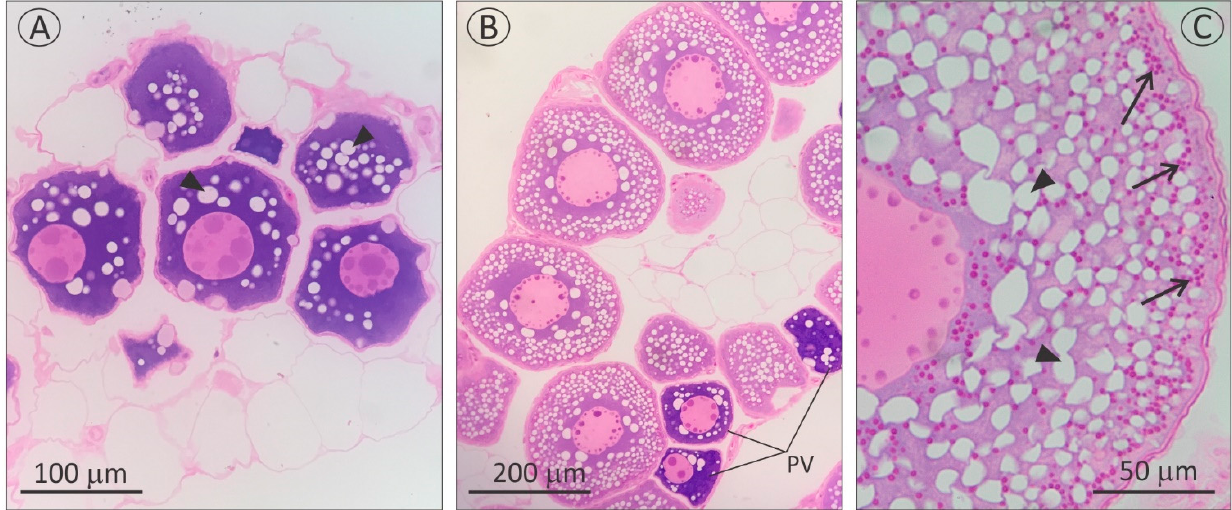
Figure 1. Histological section from pre-vitellogenic (PV: ( A )) and early vitellogenic (EV: ( B , C )) ovaries from wild-caught A. australis (year 2019). A noticeable increase in oocyte size and the presence of yolk proteins (arrows) differentiate the EV stage from the PV stage. EV ovaries normally contain few PV oocytes, as noted in ( B ). Black arrowhead: lipid droplets.